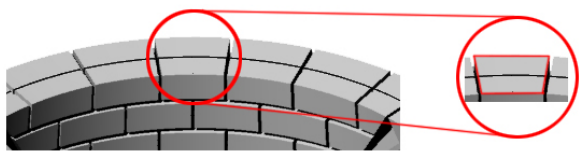
Figure 10: The conversion of bricks from a rectangular shape to a trapezoid